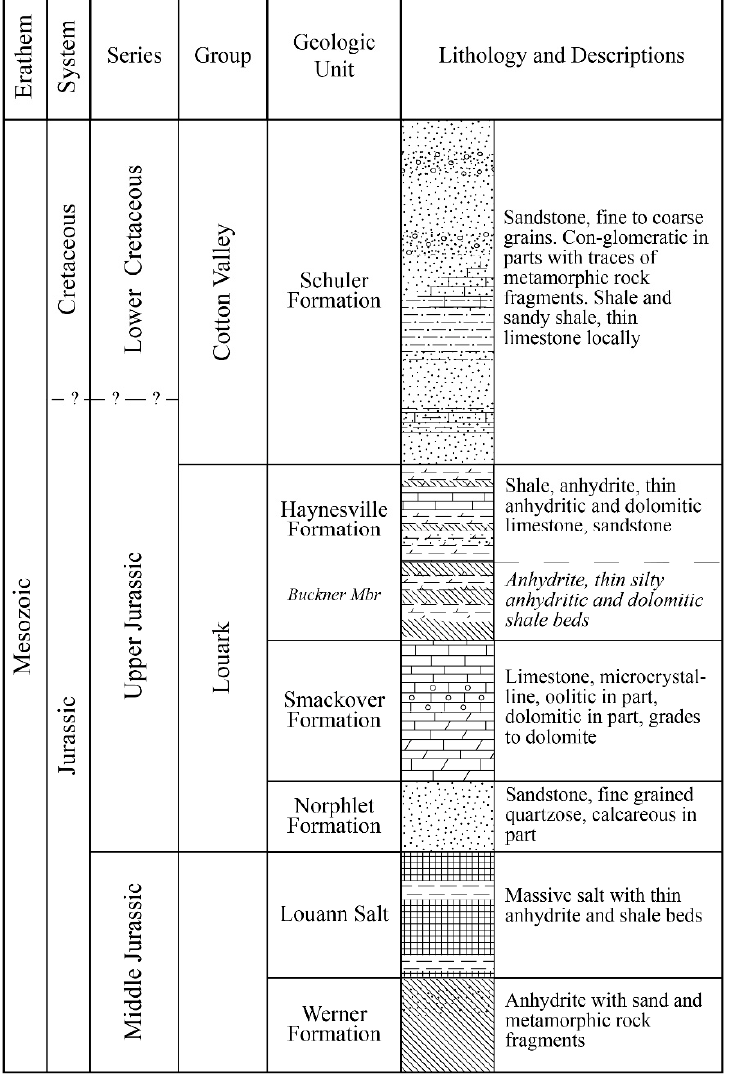
Figure 2. Regional jurassic stratigraphy of Little Cedar Creek Field and Brooklyn fields (adapted from [10]).